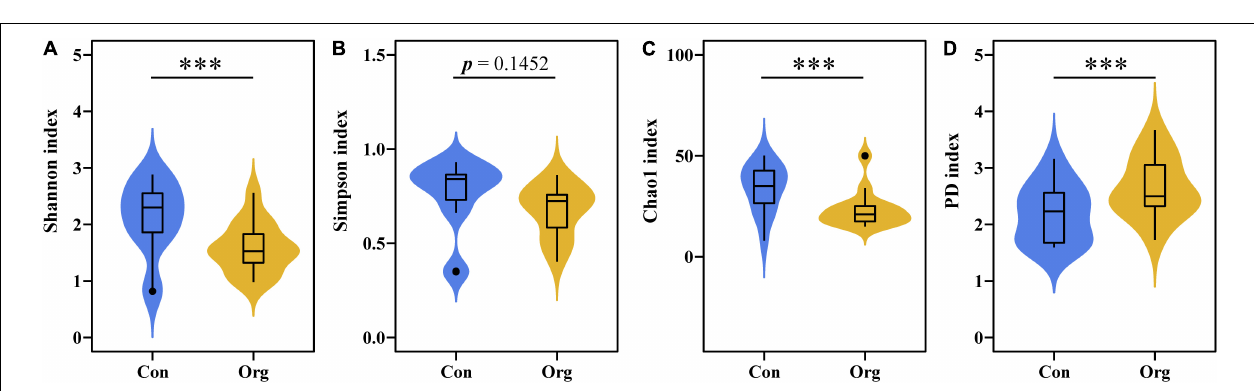
FIGURE 3 | The OTU diversity indices of AM fungal communities on conventional (Con) and organic (Org) maize farms including Shannon diversity index (A) , Simpson evenness index (B) , Chao 1 index (C) , and phylogenetic diversity index (D) . The *** represents the difference between the two farming systems is significant at P = 0.001